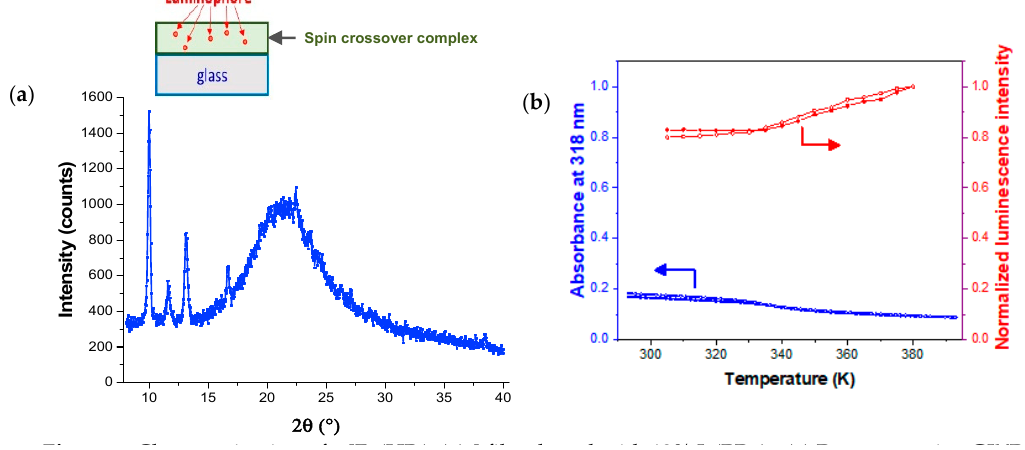
Figure 5. Characterization of a [Fe(HB(tz) 3 ) 2 ] film doped with 12% Ir(PPy) 3 . ( a ) Representative GIXRD pattern. The inset shows the outline of the sample. ( b ) Temperature dependence of the UV absorbance (318 nm) and of the luminescence intensity (excitation: 300 nm, emission 520 nm) on heating and cooling.